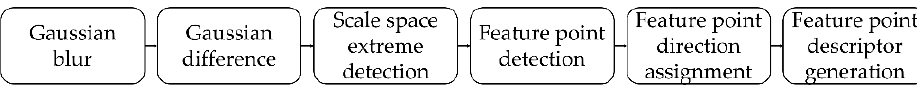
Figure 5. The pipeline of the SIFT algorithm.